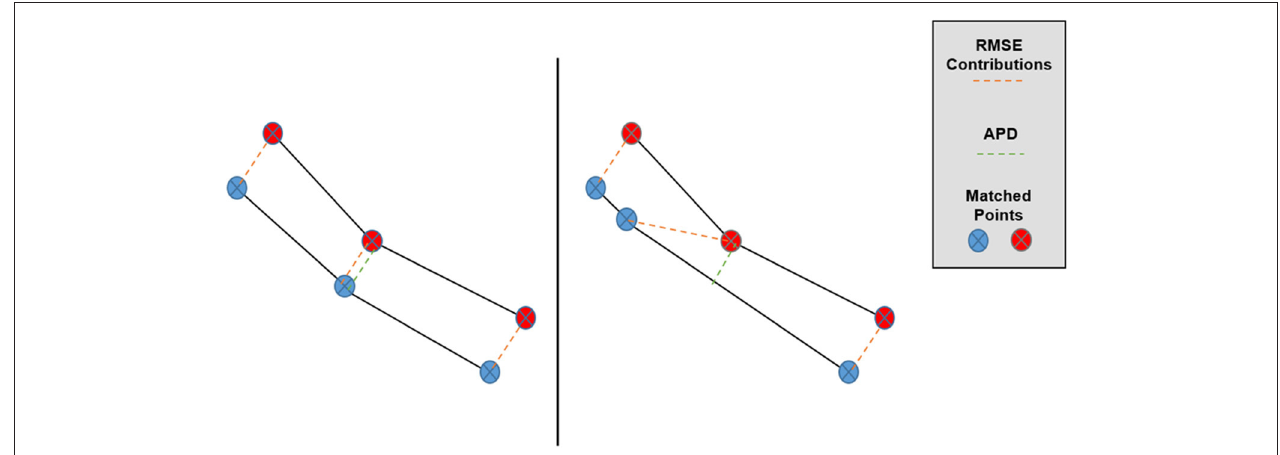
FIGURE 3 | Graphical depiction of the effect of matched point error along the Pareto surfaces on RMSE and APD. Despite the lower surfaces being very similar, the central matched pair has a much larger contribution to Pareto RMSE in the right case while the APD remains approximately the